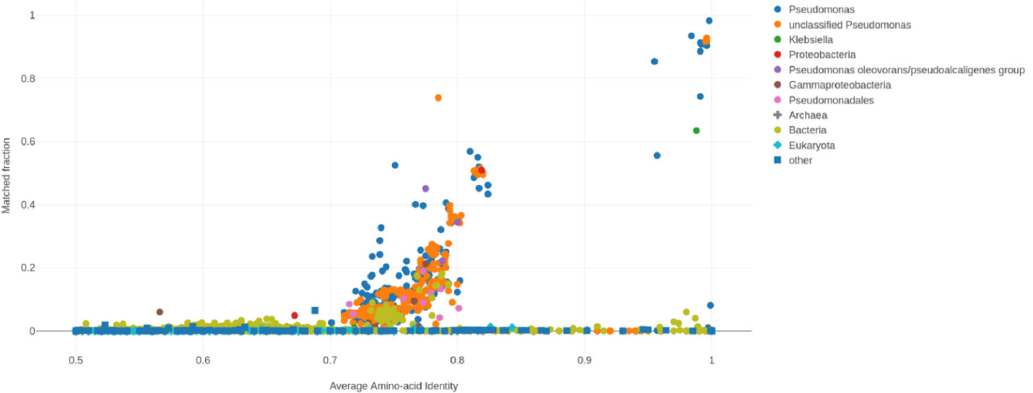
Figure 10. Average amino acid identity (AAI) values and fractional matches between various microorganisms including the FG106 strain.